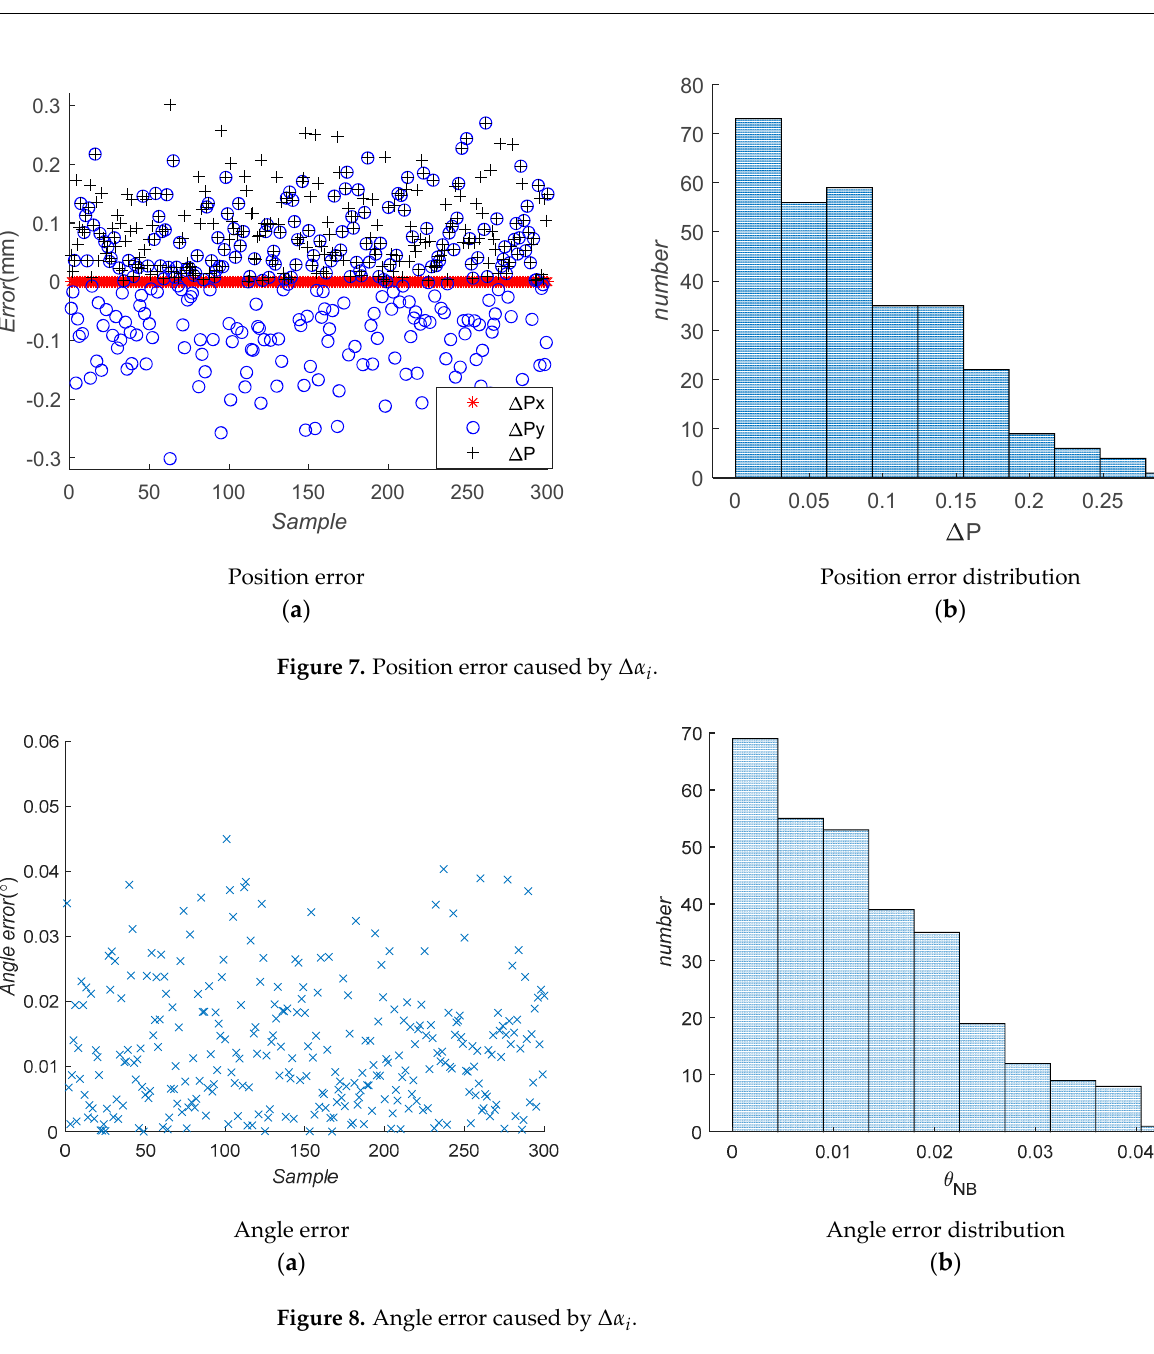
Figure 8. Angle error caused by Δ α i.